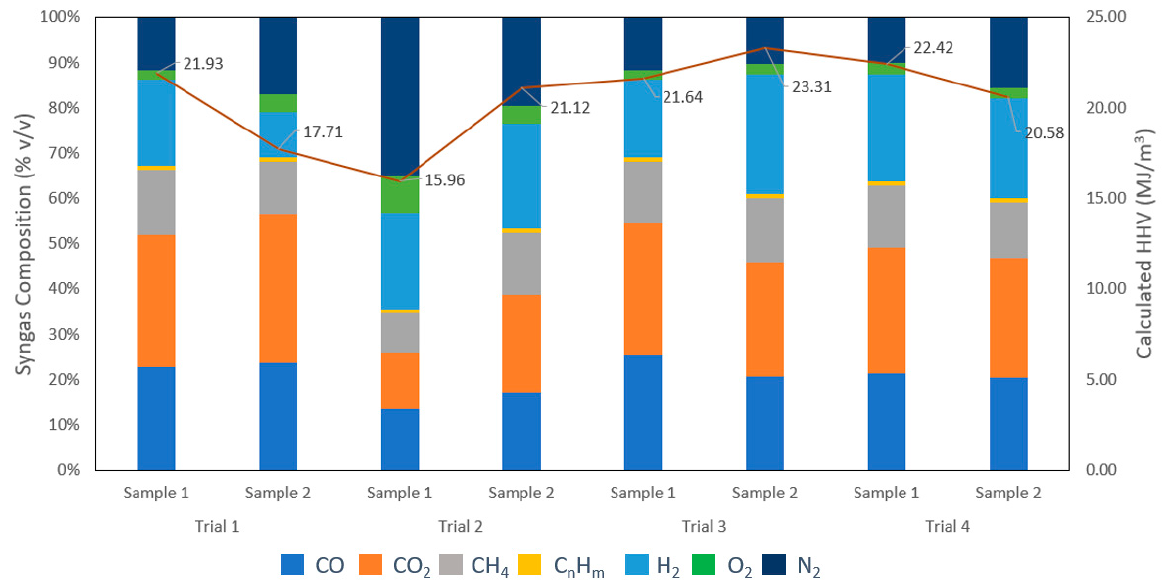
Figure 7. Chemical composition of the syngas and HHV.